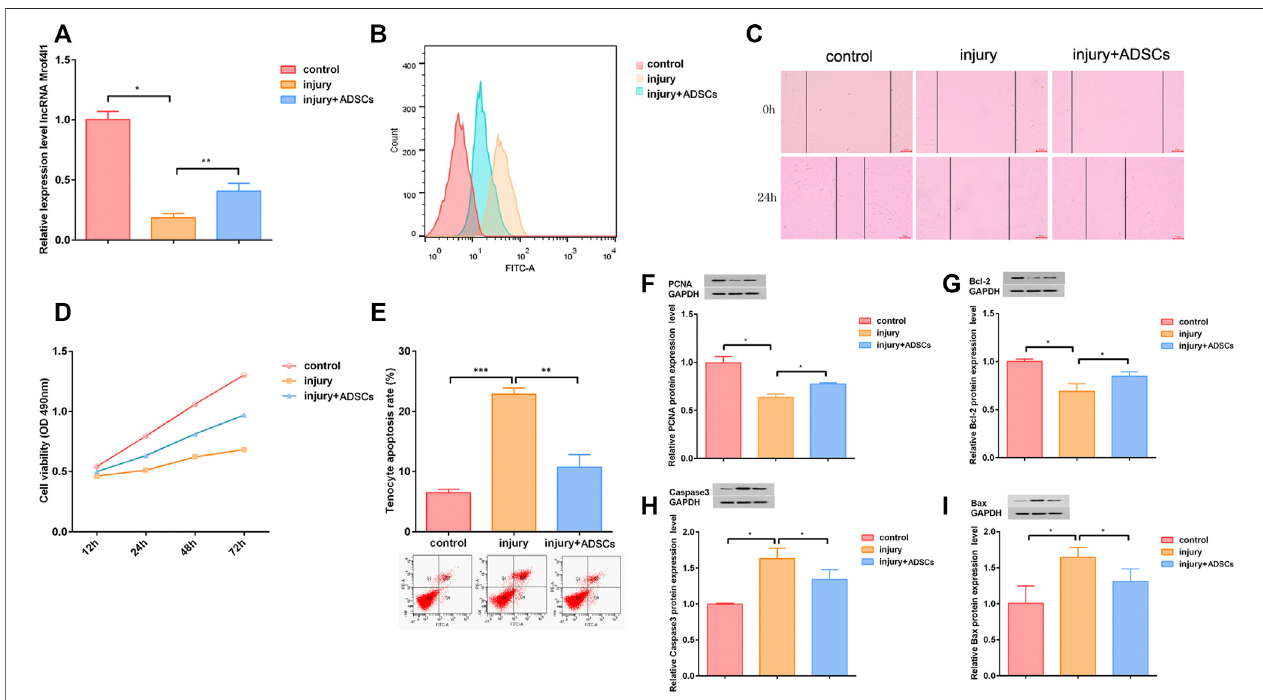
FIGURE 4 | ADSCs rescued the tendon injury in vitro . (A) The expression of lncRNA Morf4l1 increased after co-culture of injured tenocytes and ADSCs (B) The oxidative stress level of injured tenocytes was reduced after co-culture (C) Wound-healing was used to detect the effect of co-culture on the migration ability of injured tenocytes;Scale:100 μ m (D) Theproliferationabilityofinjuredtendinocytesincreasedafterco-culture (E) Theapoptosislevelofinjuredtendinocytesdecreasedafterco- culture (F – I) Westernblotwasusedtodetecttheexpression ofPCNA, Bcl-2,Caspase3 andBaxofinjuredtenocytesafterco-culture ( n =3;Mean±SD,* p < 0.05, ** p < 0.01, *** p < 0.001; Student ’ s